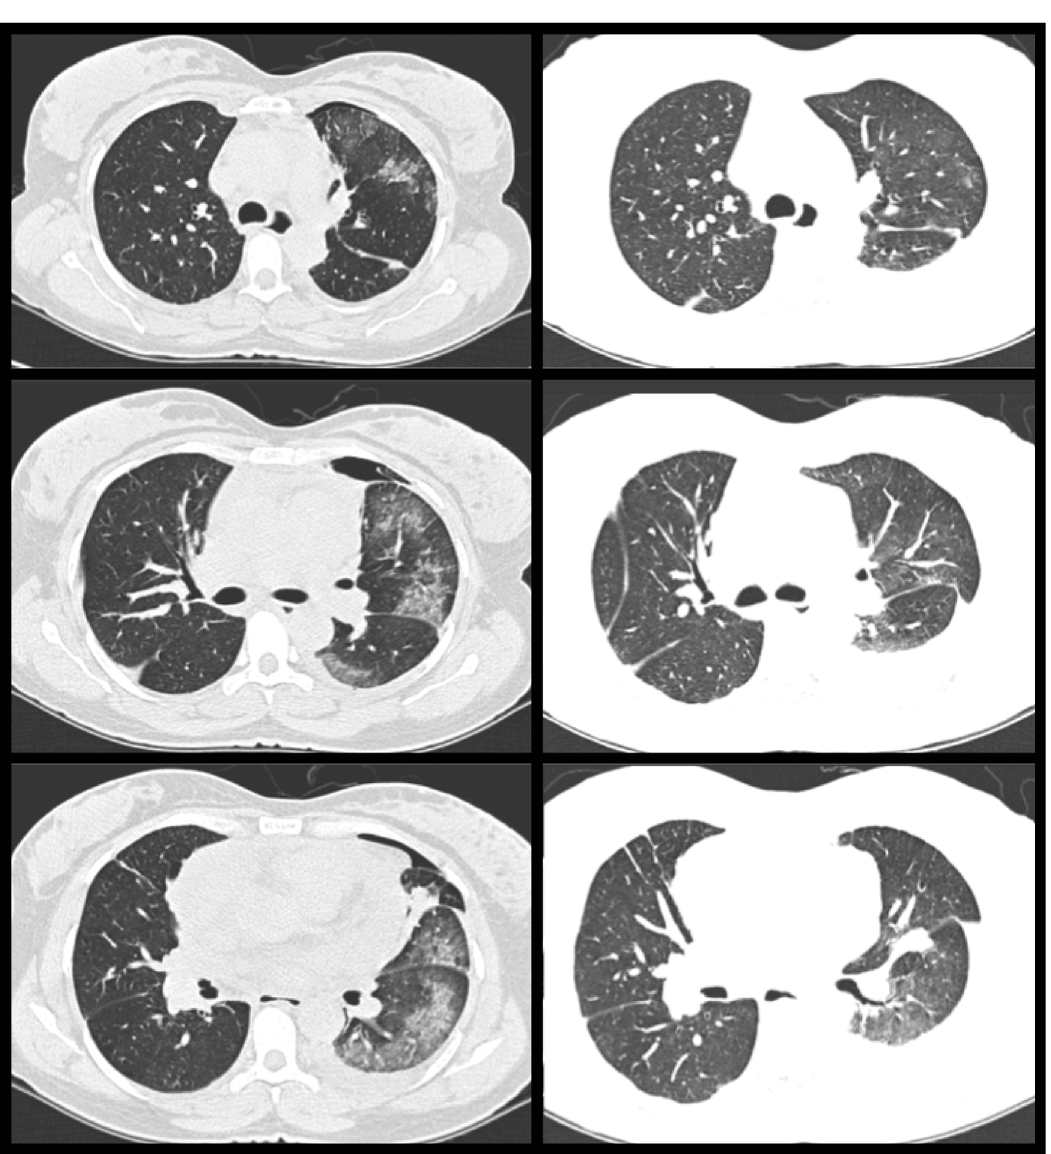
Figure 2 - Comparative analysis from computed tomography scans. On the left, images immediately after thoracocentesis; on the right, 4 days later. Although a discrete pleural effusion remains on the left, the images show a decrease in the pneumothorax and ground- glass opacities, consistent with post-thoracentesis reexpansion